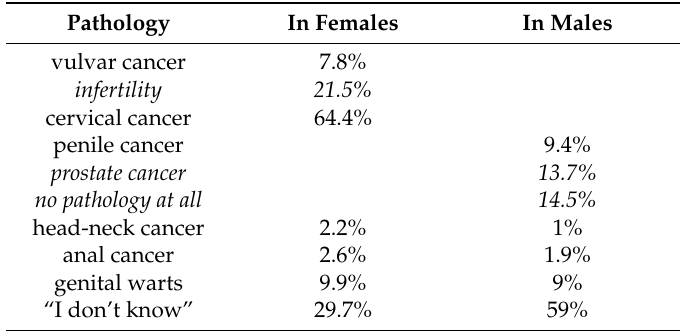
Table 1. Distribution of answers concerning pathologies associated with HPV infection.